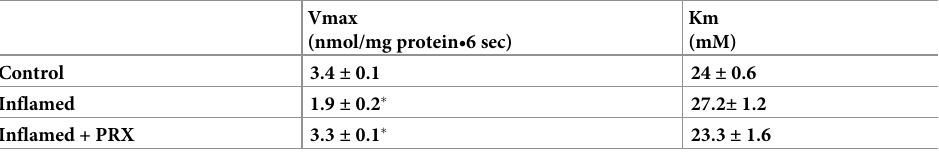
Table 2. Kinetic parameters of Na-glutamine co-transport in PRX treated villus cell BBMV.